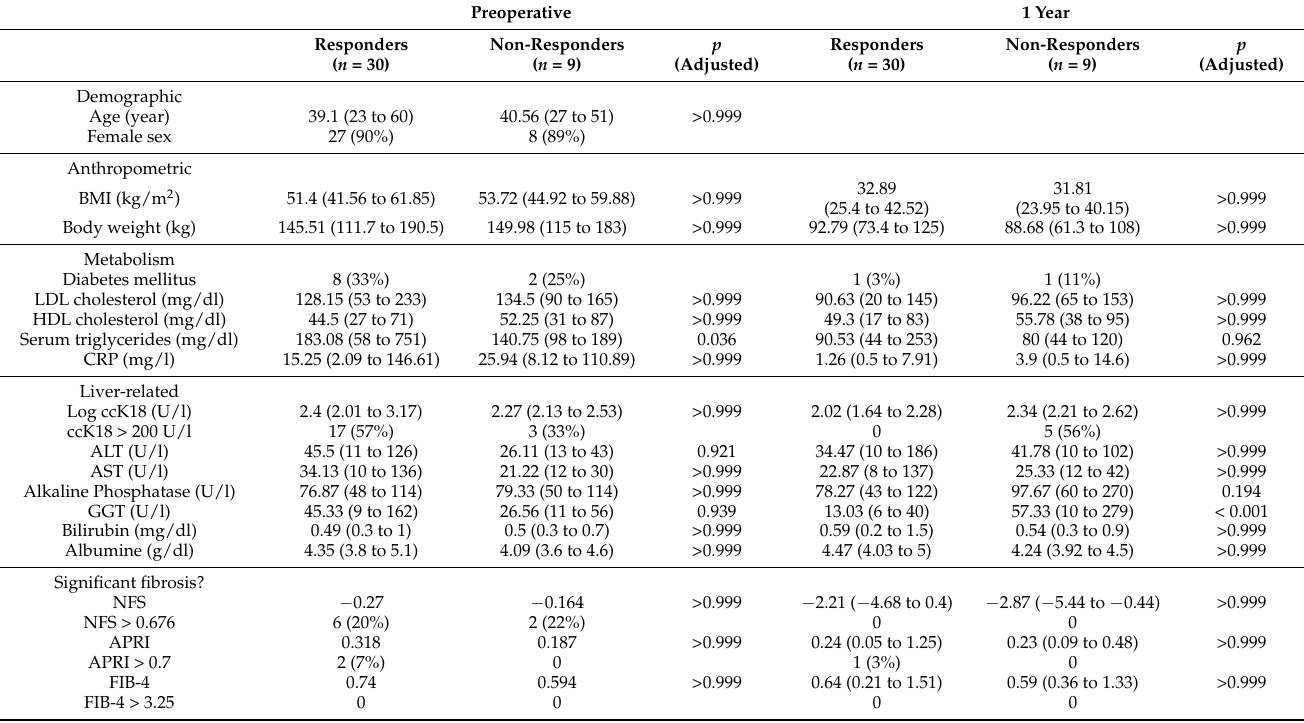
Table 2. Comparison of responders and non-responders before and one year after